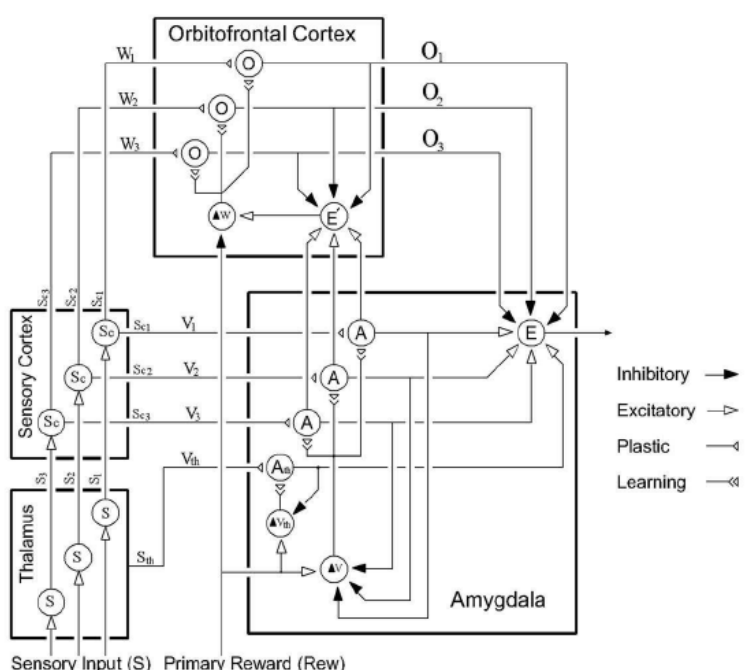
Figure 5. Graphical design of single-layer emotional controller, adopted from [22].